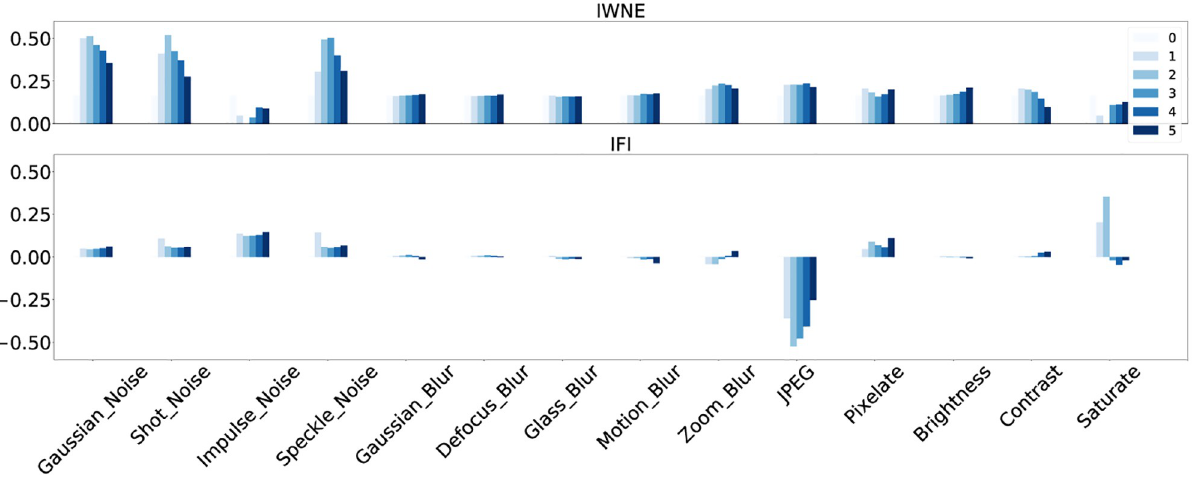
Fig 4. This figure shows the robustness to distortions for the different models. The difference in the softmax probabilities of the output between the CL and FS model is plotted here. The intensity of the color indicates the severity of the distortions. Top row shows the difference for IWNE models. Bottom row shows the difference for IFI models. In case of IWNE, the difference is consistently positive, implying that the self-supervised model has a higher prediction score than the plainly supervised model and thus exhibits a higher robustness to distortions. See Section Robustness to Distortions: for a detailed